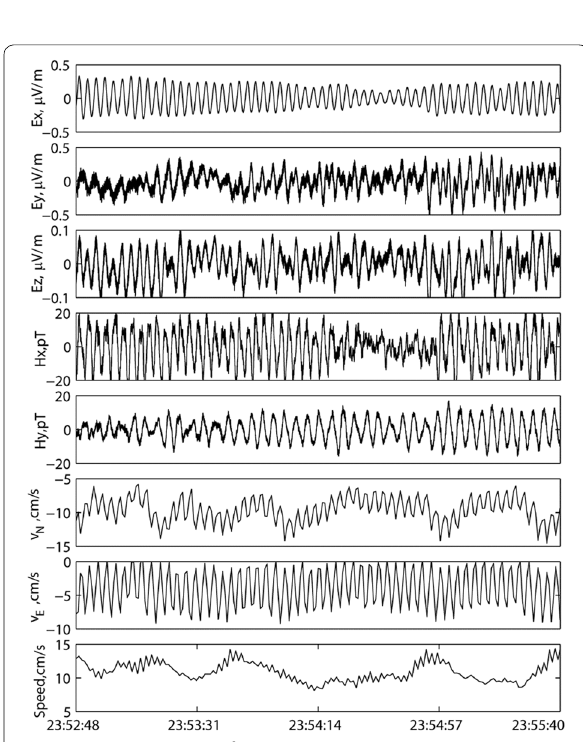
Fig. 5 A 172-s time series from site SH-R11 at August 24, 2018, when the velocity of the time section was relatively large. The five EM components (Ex/Ey/Ez/Hx/Hy) are derived from the OBEM data logger with a 150 Hz sampling rate, and the bottom three components ( v E / v N /Speed) originated from the current meter with a sampling rate of 1